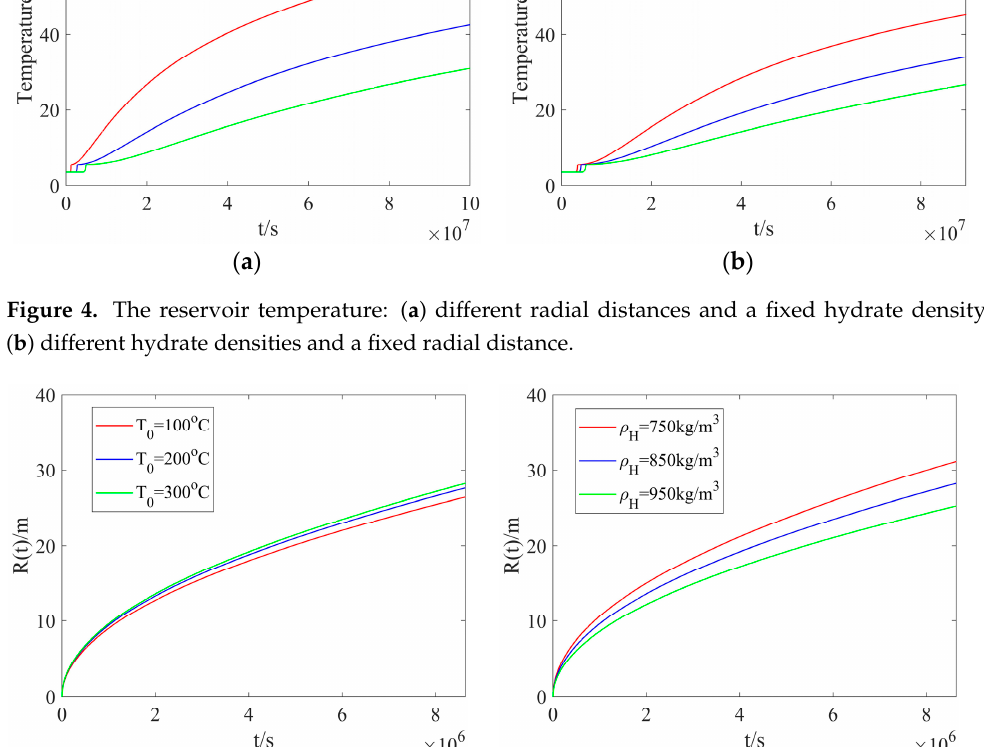
Figure 4. The reservoir temperature: ( a ) different radial distances and a fixed hydrate density; ( b ) different hydrate densities and a fixed radial distance.